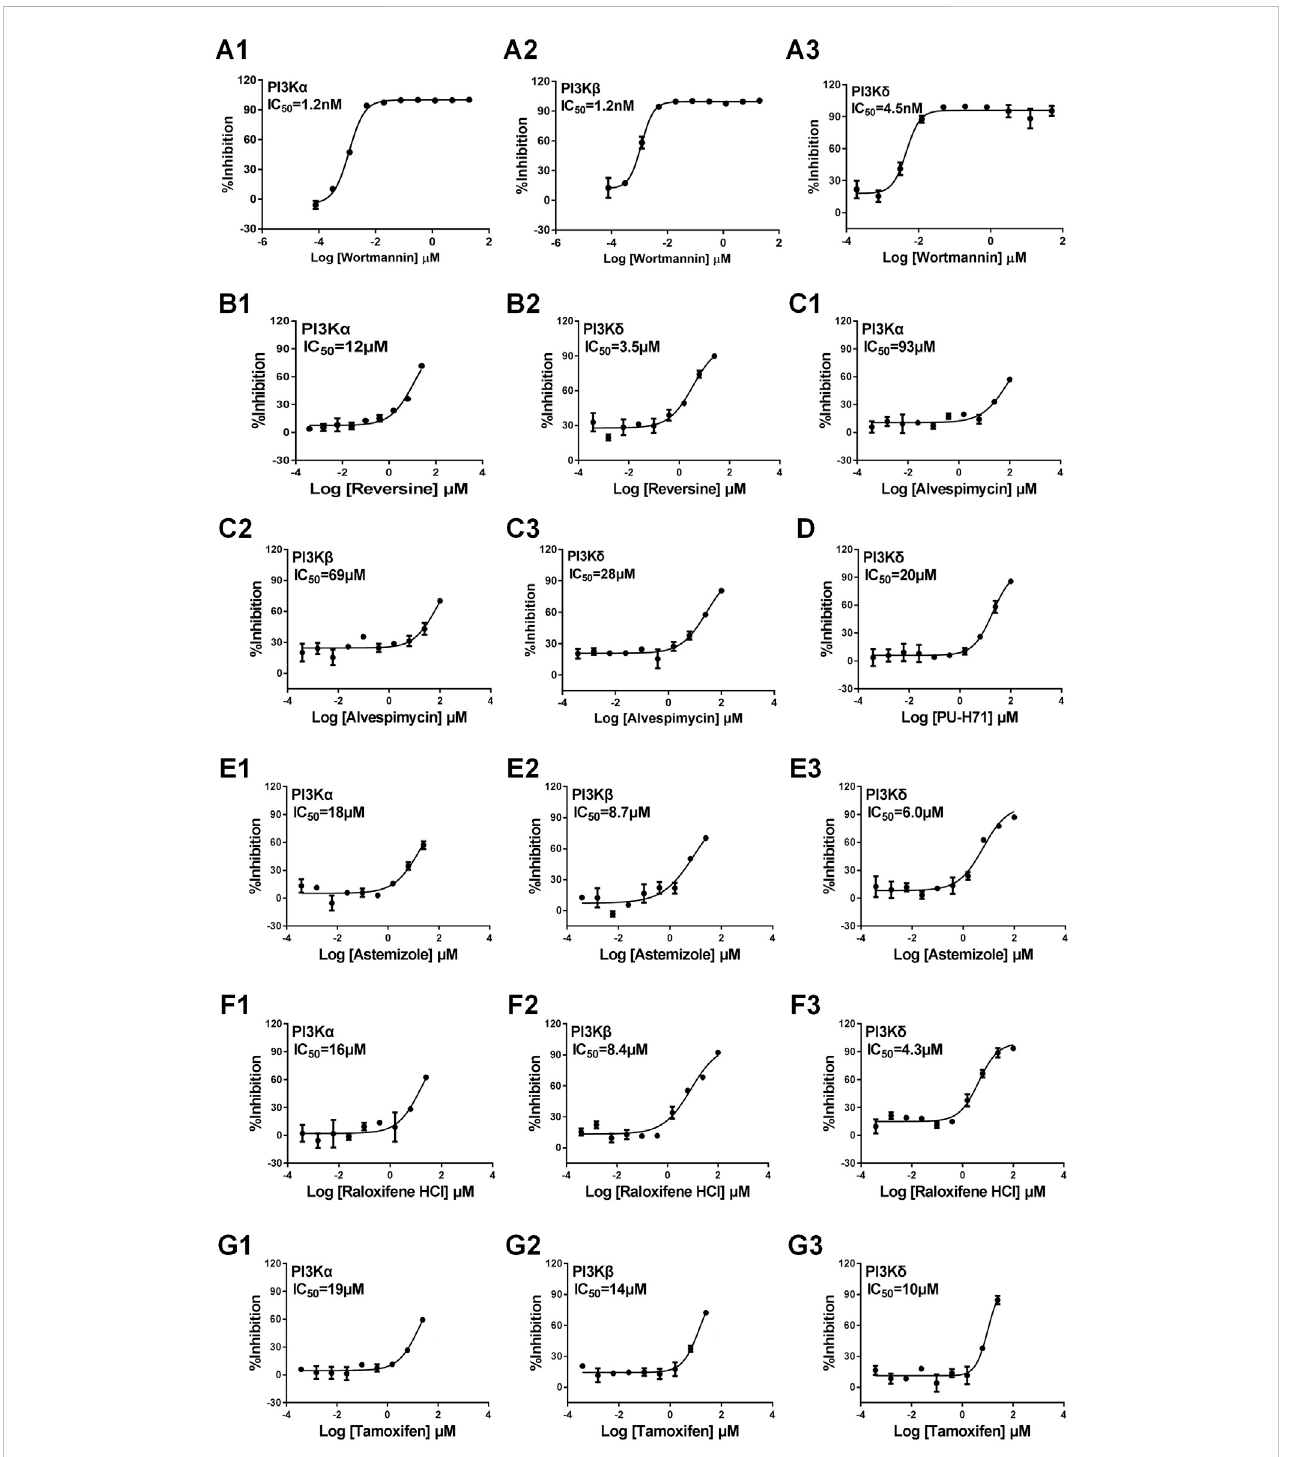
FIGURE 4 Experimental validation of interaction between the test compound and PI3K α / β / δ . We used the classical PI3K inhibitor wortmannin as the positive control. (A1 – 3) : Wortmannin and PI3K α / β / δ ; (B1 – 2) : Reversine and PI3K α / δ ; (C1 – 3) : Alvespimycin and PI3K α / β / δ ; (D) : PU-H71 and PI3K δ ; (E1 – 3) : Astemizole and PI3K α / β / δ ; (F1 – 3) : Raloxifene HCL and PI3K α / β / δ ; (G1 – 3) : Tamoxifen and PI3K α / β / δ . Data are presented as mean ± SEM, with n = 3 for each drug